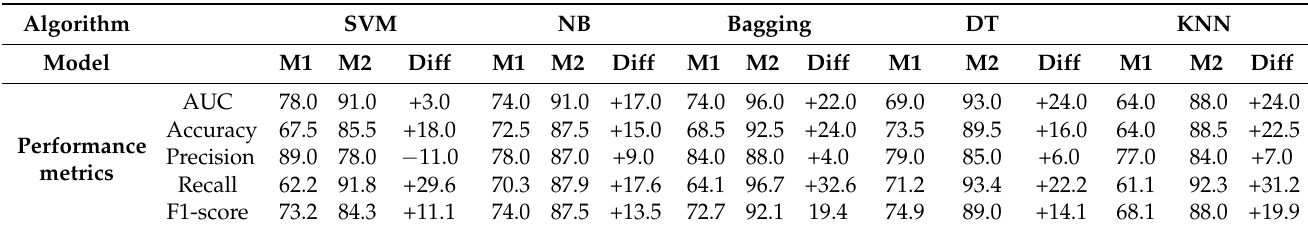
Table 7. Comparison of the evaluation indicators between the two